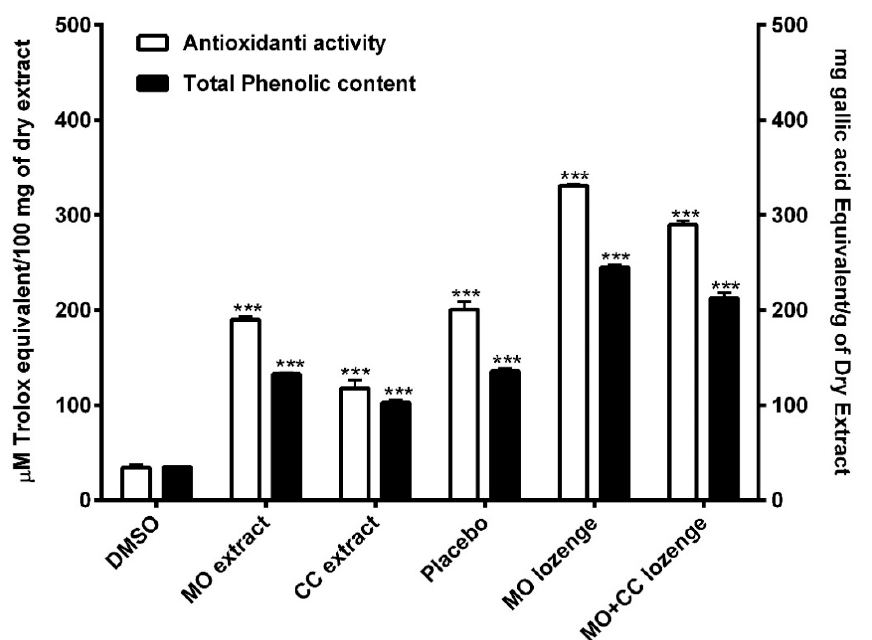
Figure 2. Antioxidant activity of extracts and lozenges are shown in white bars. Total phenolic contents of extracts and all lozenges are presented in black bars. DMSO: dimethyl sulfoxide; MO extract: Moringa oleifera extract; CC extract: Cyanthillium cinereum extract; MO lozenges: Moringa lozenges; MO + CC: Moringa and Cyanthillium lozenges. Data are presented as means ± SEM. *** p < 0.001, compared to DMSO.